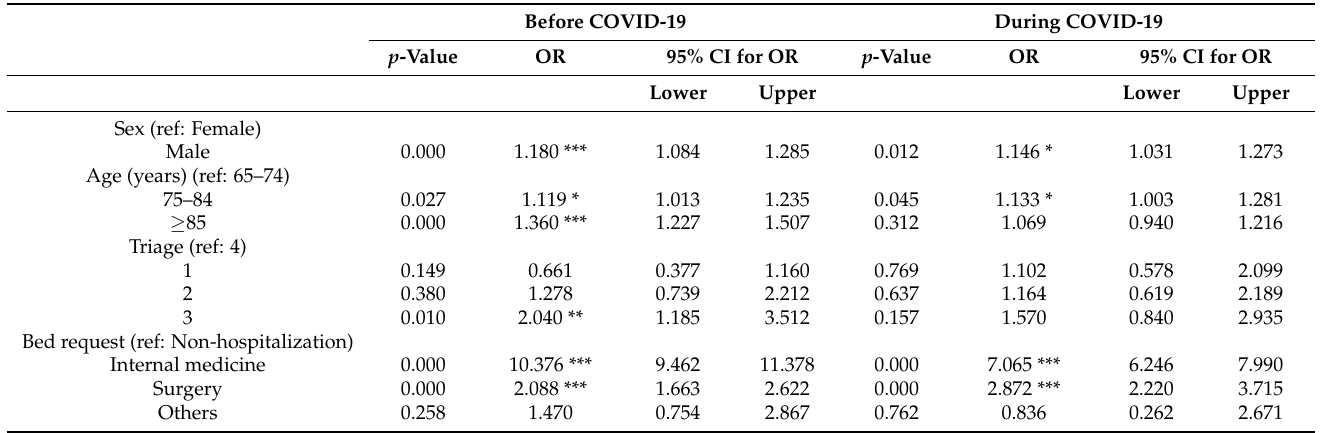
Table 5. Logistic model regression results for the predictors of EDLOS ≥ 24 h comparing the COVID- 19 pandemic to the pre-pandemic